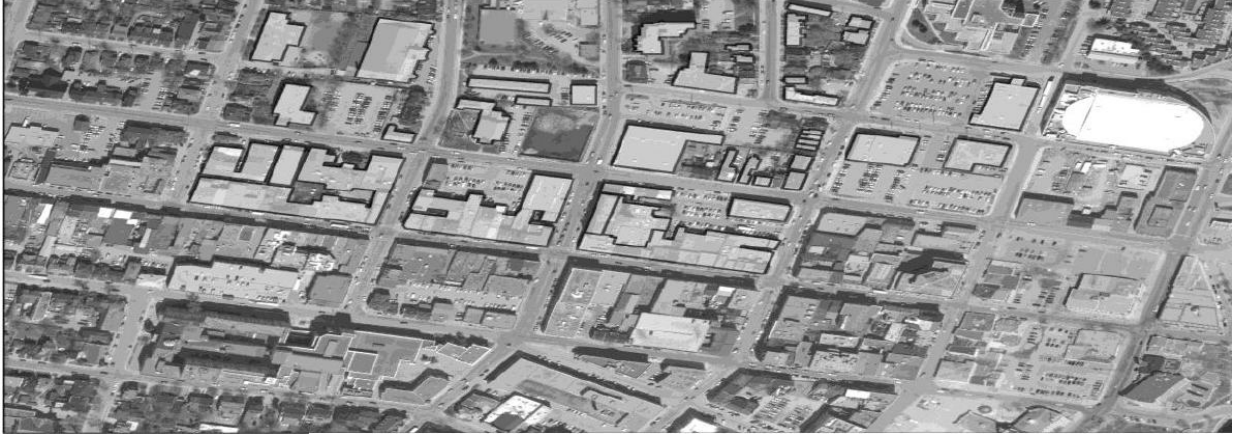
Figure 1. The case study area, a portion of Kingston, Ontario and in particular the Princess Street downtown corridor. The chosen buildings are delineated with bold black lines and greyed